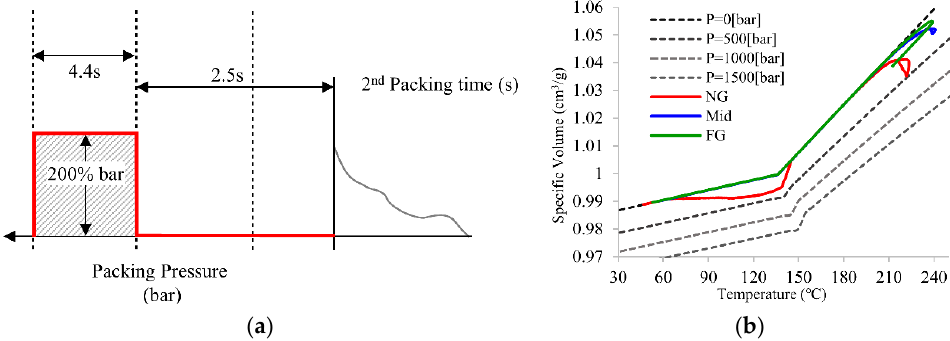
Figure 8. ( a ) Principle of intermittent packing pressure setup and ( b ) PVT processing path of principle of intermittent packing pressure setup for the Mid section.